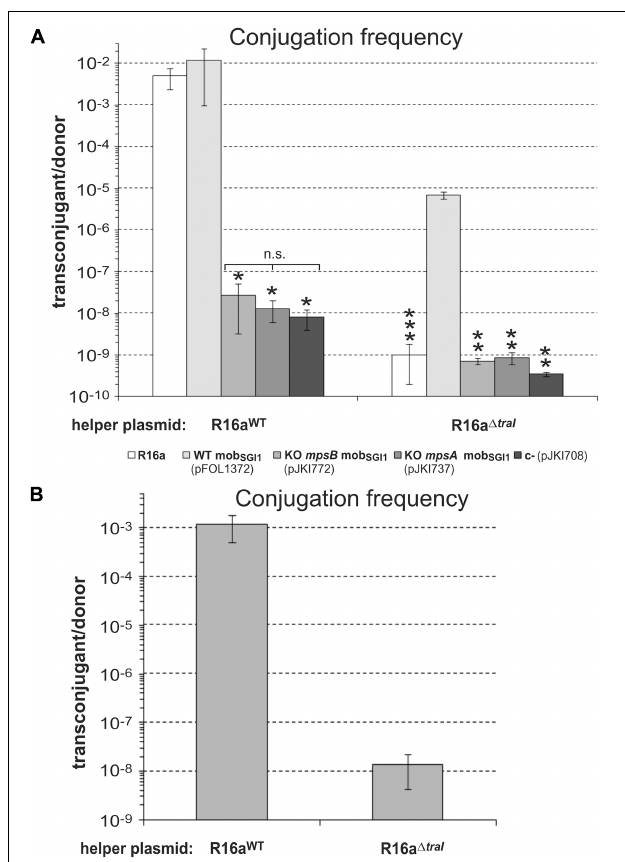
FIGURE 4 | The role of mpsA , mpsB and the helper encoded relaxase traI in SGI1 mobilization. (A) Transfer frequency of the p15A-based plasmids, containing WT (pFOL1372), KO mpsB (KO S019, pJKI772) and KO mpsA (KO S020, pJKI737) mob SGI1 regions was assayed in the presence of the WT or relaxase KO mutant helper plasmid R16a. For mating, TG1Nal donor and TG90 recipient E. coli strains were used. The bars show means of 4 independent experiments except those representing the transfer rate of the helper plasmids. Since the conjugation frequency of the helper plasmids was the same independently of the test plasmids, the transfer rate of the helper plasmids R16a WT and R16a (cid:49) TraI correspond to the mean of their transfer frequencies in the 4 different settings that have been repeated 4 times. ∗ Transconjugants indicated by an asterisk carried also the helper plasmid (co-transfer was ∼ 100 %) suggesting that the transfer of test plasmids did not derive from regular trans -mobilization. ∗∗ Transfer frequency was below the detection limit (transconjugants were not obtained). ∗∗∗ Transfer frequency of R16a (cid:49) TraI was close to the detection limit, 6 transconjugant colonies were obtained from five independent experiments (mean frequency was ≤ 1.9 × 10 − 9 ). These colonies did not contain test plasmid. (B) Mobilization of SGI1-C WT by the helper plasmids R16a WT and R16a (cid:49) TraI from TG1Nal::SGI1-C donor into TG90 recipient